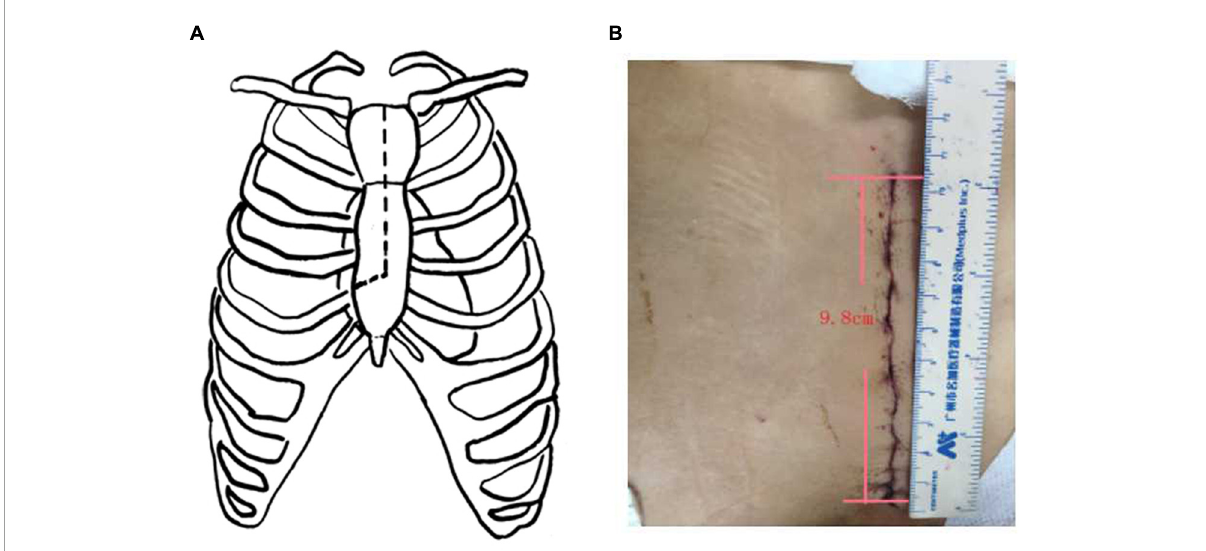
FIGURE2 Upper J ministernotomy. (A) : The schematic diagram of upper J ministernotomy. (B) : Upper J ministernotomy after suture. The length of the incision was nearly 9 cm.